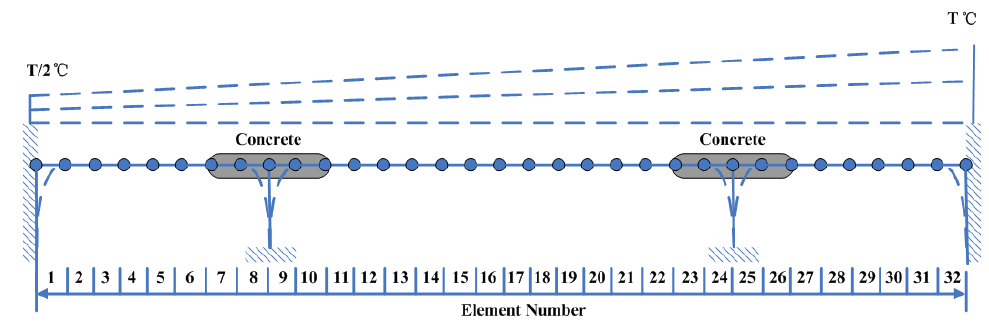
Figure 3. Simulated bridge-like structure.